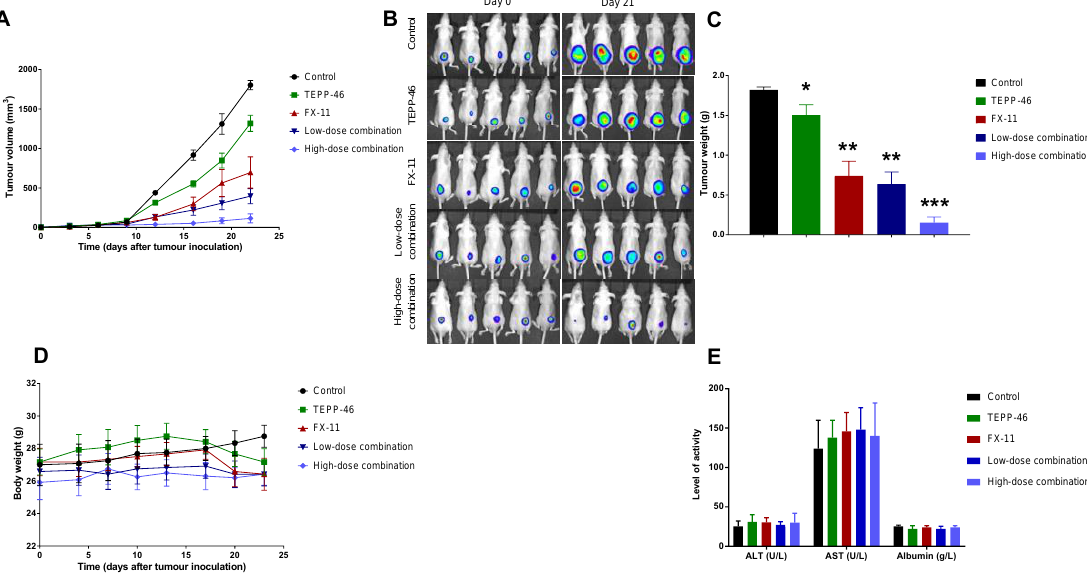
Figure 3. E ffi cacy and toxicity evaluation of TEPP-46, FX-11, and combination therapy in the subcutaneous BxPc-3-Luc tumor model. E ffi cacy was evaluated based on ( A ) Tumor volume over time, ( B ) Bioluminescent images of mice from each treatment group at the start and end of treatment (day 0 and day 21, respectively), and ( C ) Tumor weights at the end of treatment. Toxicity was evaluated based on change in ( D ) Weight of mice over the course of therapy and ( E ) Liver enzyme function and albumin. Each treatment significantly delayed tumor growth compared with the control group; FX-11, low- and high-dose combination therapy significantly reduced tumor growth compared with TEPP-46, and the high-dose combination therapy significantly reduced tumor growth compared with all other treatments ( p < 0.05, 2-way ANOVA and multiple t-tests). No significant weight loss or change in liver enzyme function and albumin were encountered in the treatment groups compared with control mice. Data presented as mean ± SE; * indicates significantly di ff erent from controls; ** indicates significantly di ff erent from controls and TEPP-46; *** indicates significantly di ff erent from controls and all other treatment